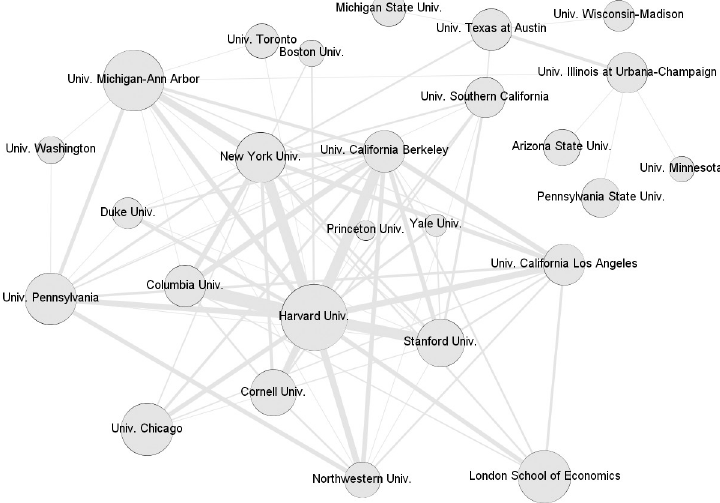
Fig 6. Projection of institutions for the overall network. Size of each node is proportional to the number of different scholars from the institution who are on EBs. Thickness of the lines is proportional to the number of common scholars in EBs between the institutions